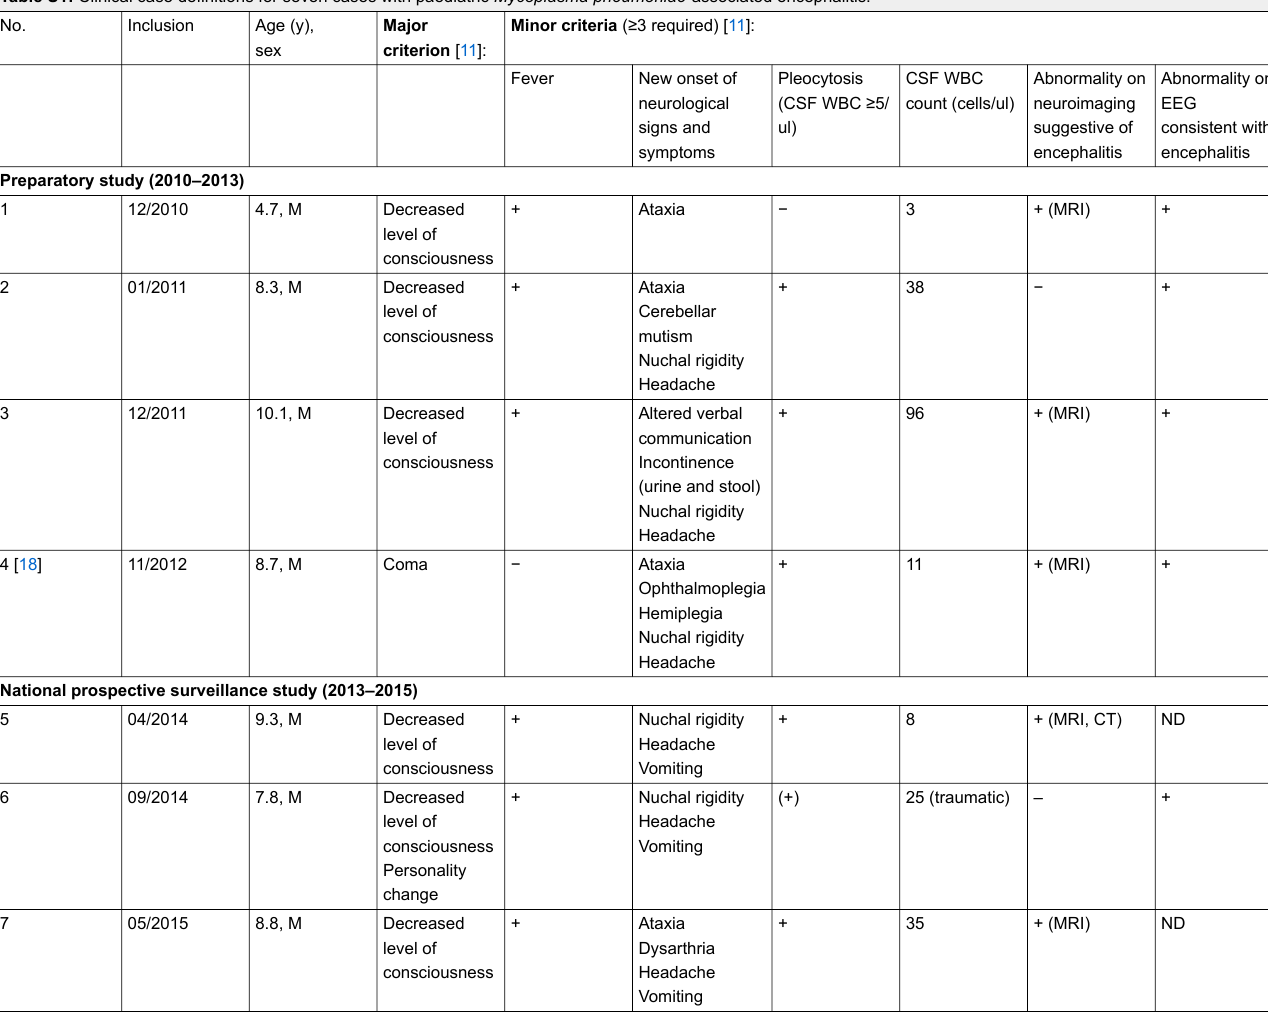
Table S1: Clinical case definitions for seven cases with paediatric Mycoplasma pneumoniae -associated encephalitis.